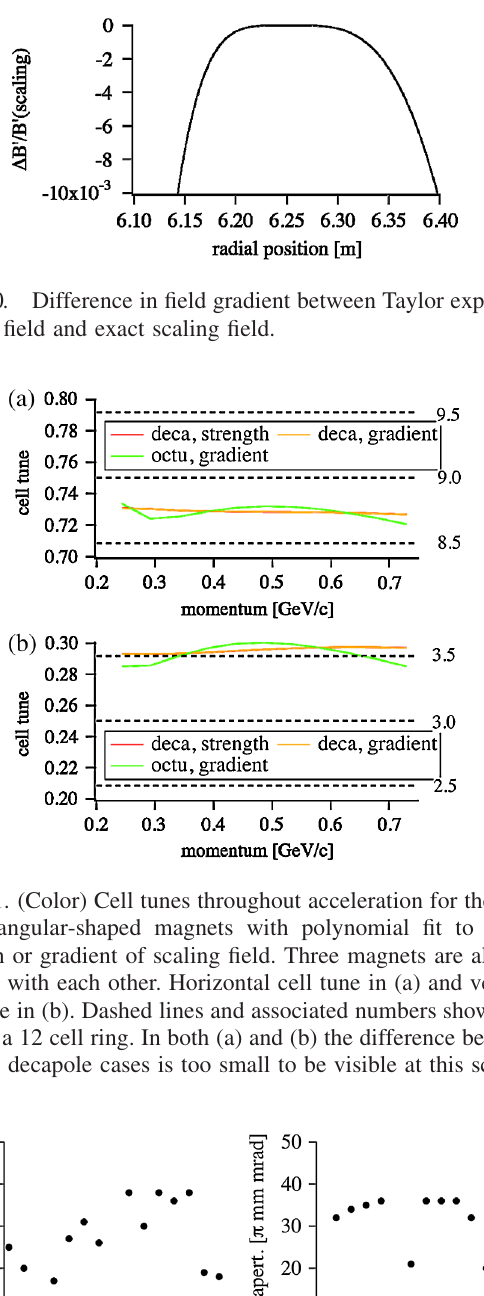
. The lattice of rectangular-shaped y